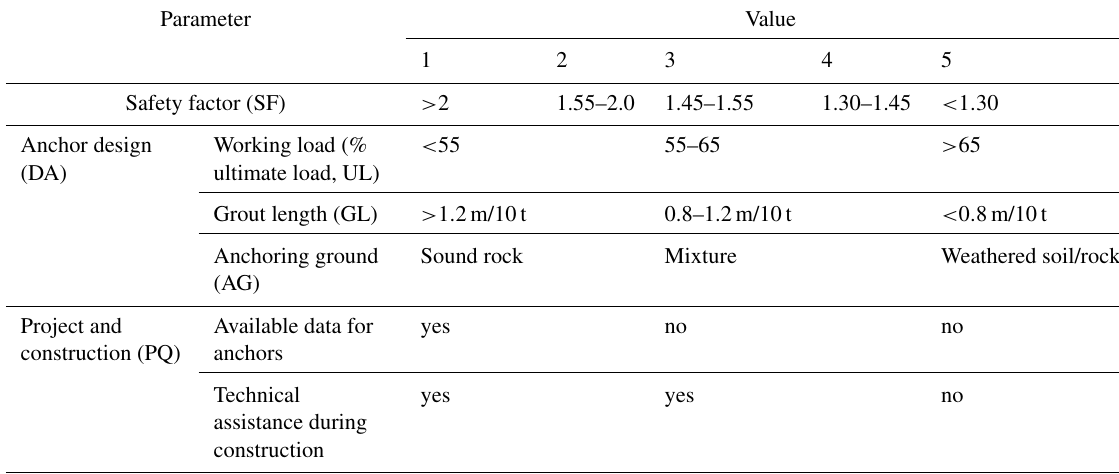
Table 6. Scores the hazard index (HI) components for the failure of retaining walls.